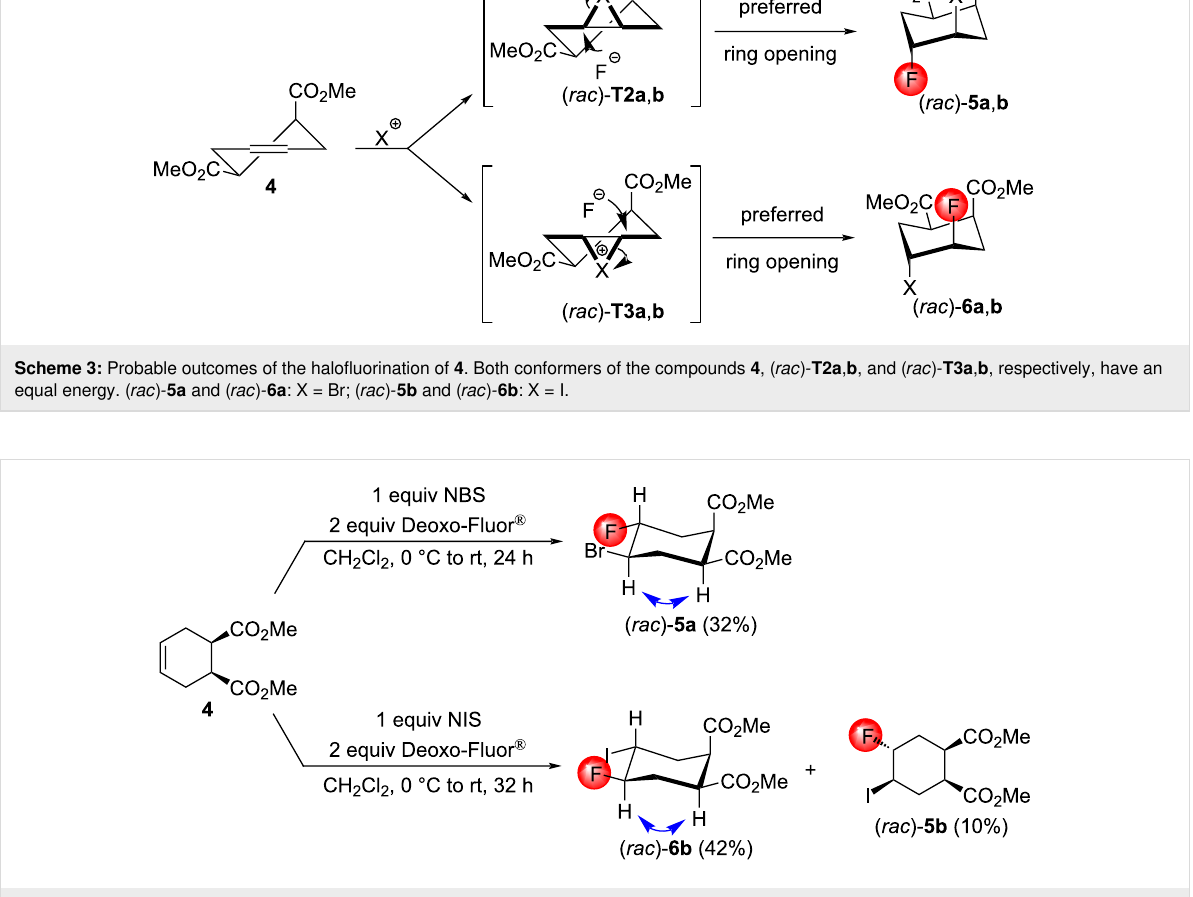
Scheme 4: Halofluorination reactions of the cis -diester 4 . Important NOESY interactions are indicated by two-headed